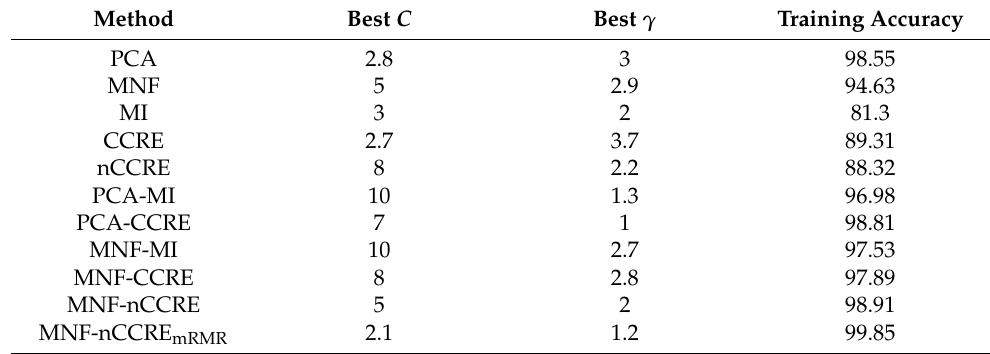
Table 6. Parameter tuning results using tenfold cross-validation for the AVIRIS IP dataset.